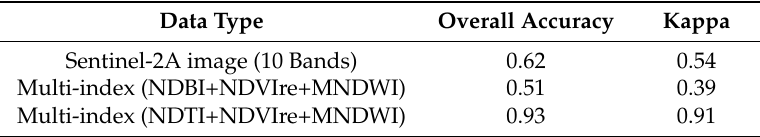
Table A4. Comparison of the overall accuracy and Kappa statistics for Figure 9.